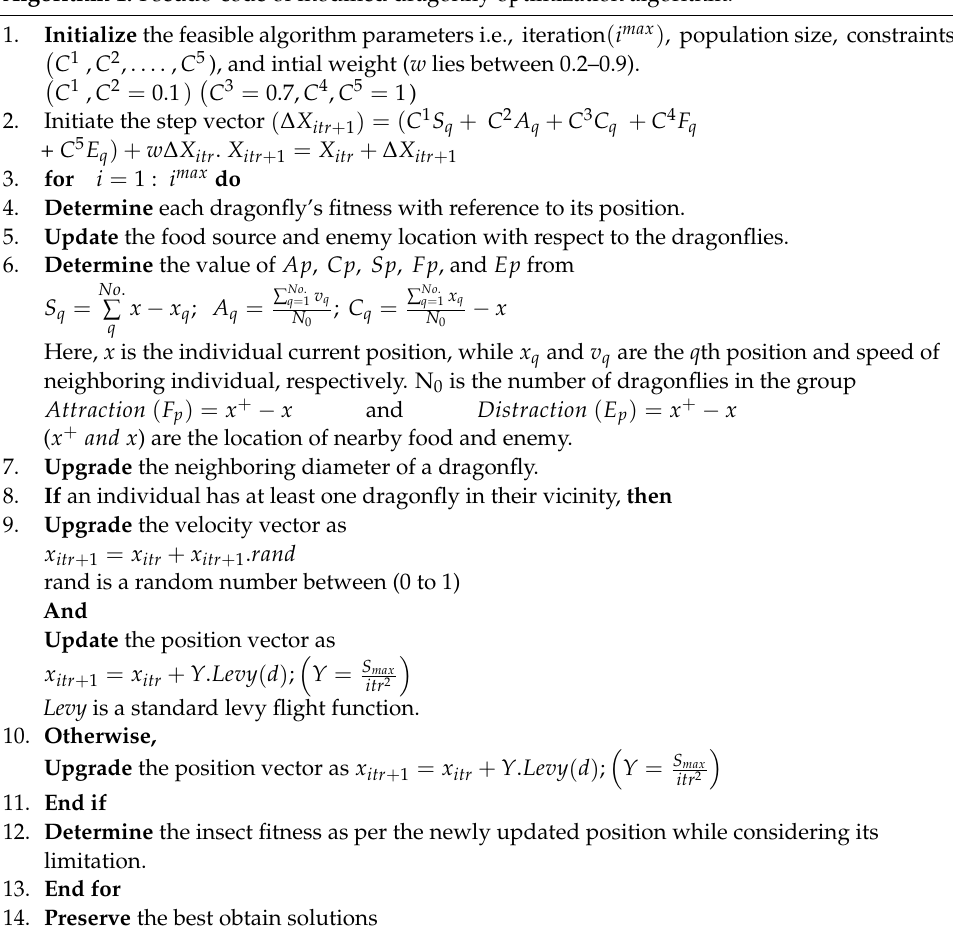
Algorithm 1. Pseudo-code of modified dragonfly optimization